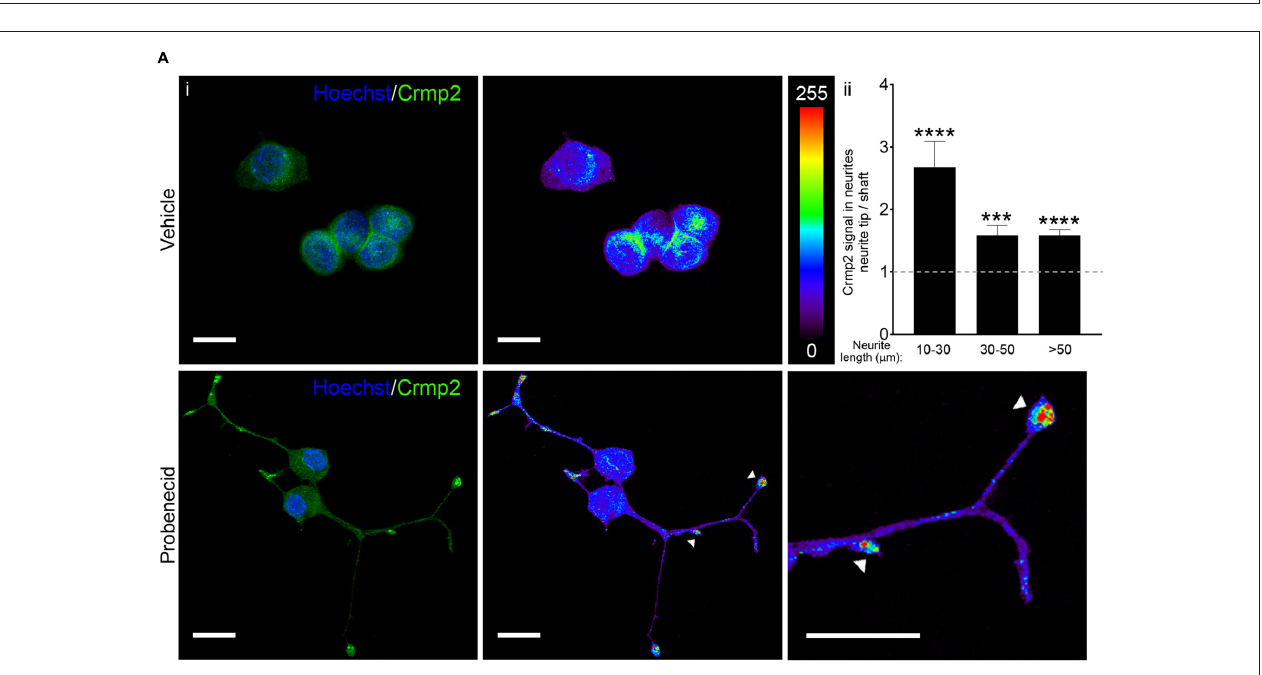
FIGURE 5 | Probenecid treatment results in Crmp2 concentration at neurite tips. (Ai) Representative confocal images from N2a cells treated with vehicle (upper panels) or probenecid (lower panels) and immunostained for Crmp2. Crmp2 signal intensity is indicated in the heat maps. Hoechst 33342 was used as a nuclear counterstain. Scale bars: 20 µ m. (ii) Crmp2 signal in probenecid-induced neurites was more abundant in neurite tips compared to the shaft, regardless of neurite length (10–30 µ m, p < 0.0001, n = 38 neurites; 30–50 µ m, p = 0.0003, n = 40 neurites; >50 µ m, p < 0.0001, n = 48 neurites; Wilcoxon signed-rank test against a hypothetical median value of